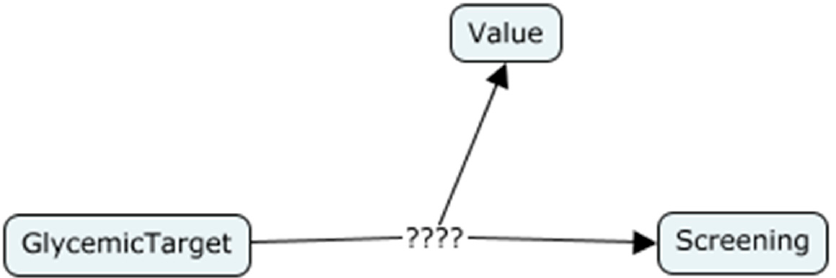
Figure 4. Before applying n-ary design pattern 1.